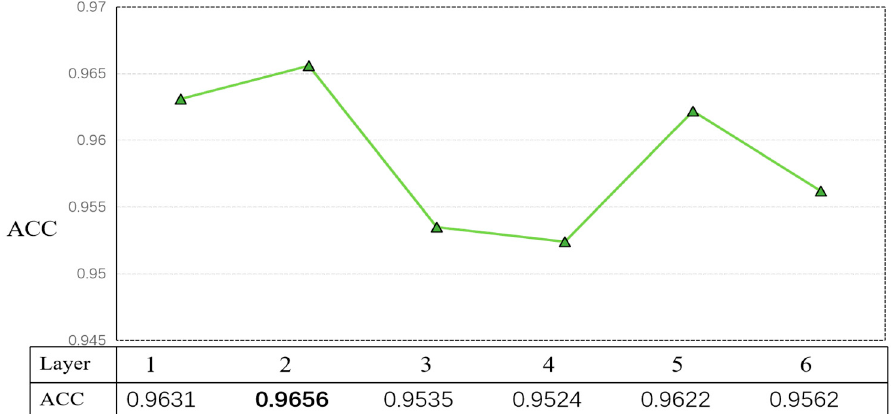
Figure 12. Relationship between GCN layer and accuracy, tested when m = 0.2 and dropout = 0.1 for GCN-layer. The results showed that the best results were obtained when GCN-layer = 2, leading by 0.25. The bolded font in the figure is the optimal effect.